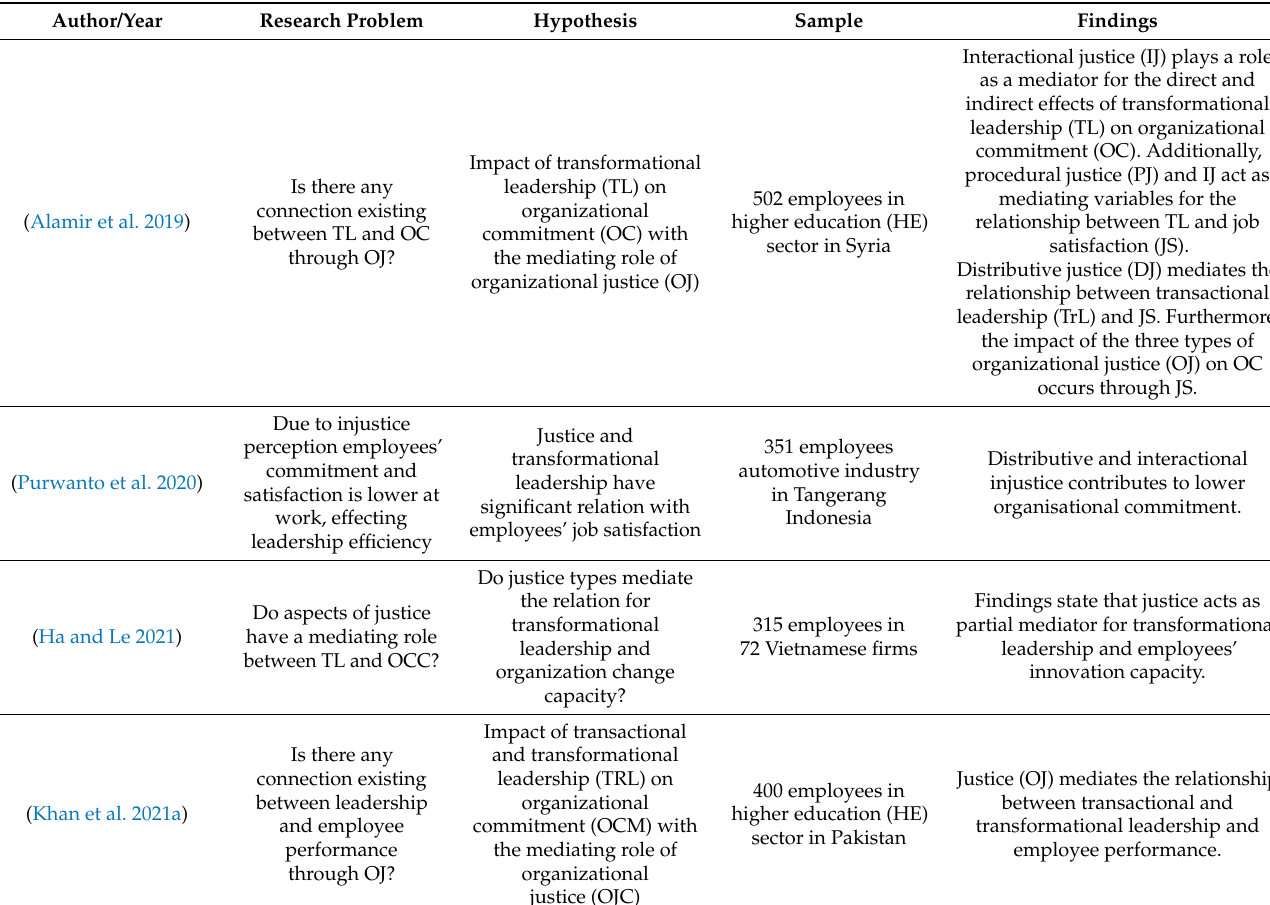
Table 1. Existing